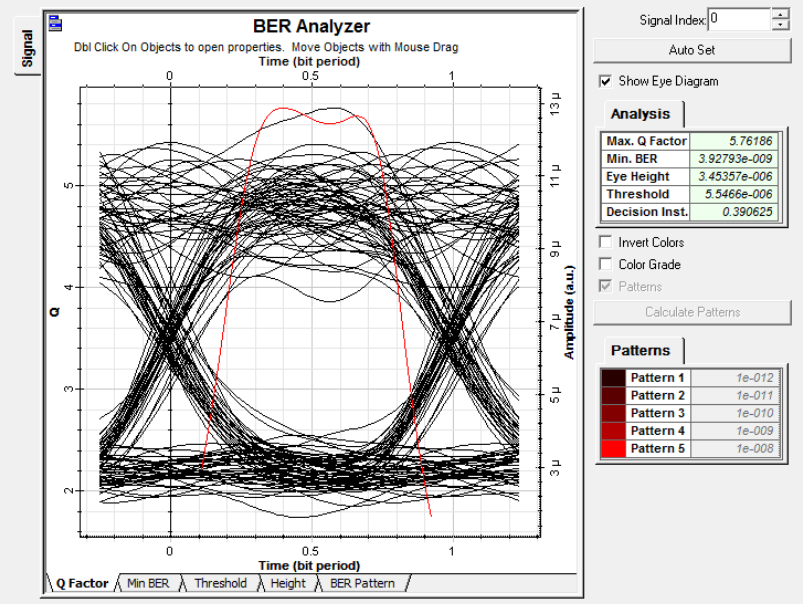
Fig. 11 Eye diagram showing BER performance on heavy dust 242 dB/km of two channels with EDFA FSO system at 380